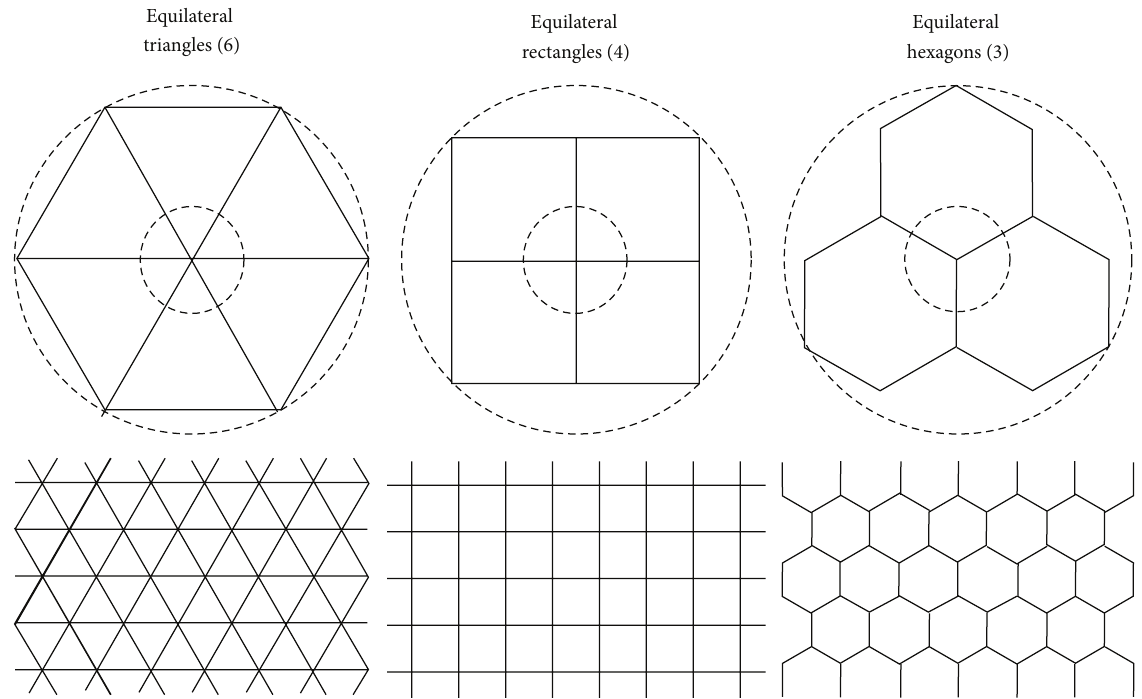
Figure 1: Basic formation and combination formula of a